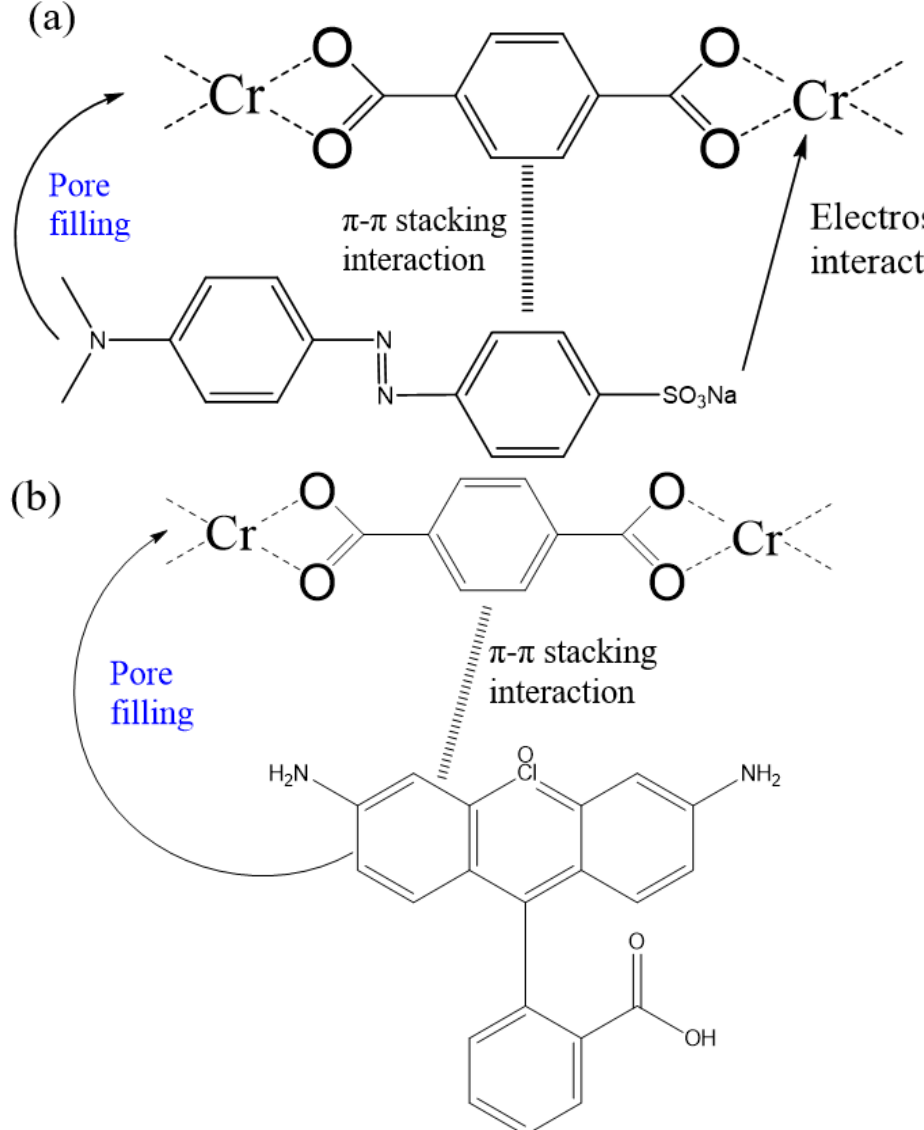
Figure 4. Possible mechanism of synergetic interplay for ( a ) MO and ( b ) RB adsorption on 160-MIL- 101.